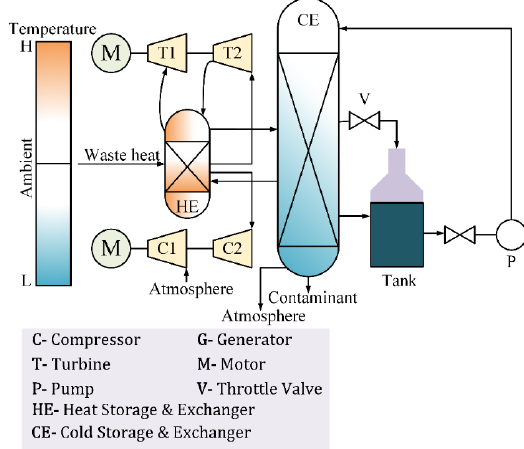
Figure 9. Schematic diagram of SC-CAES system, where air is pressurized into a supercritical state at high temperature and pressure, and then expanded when required [36].